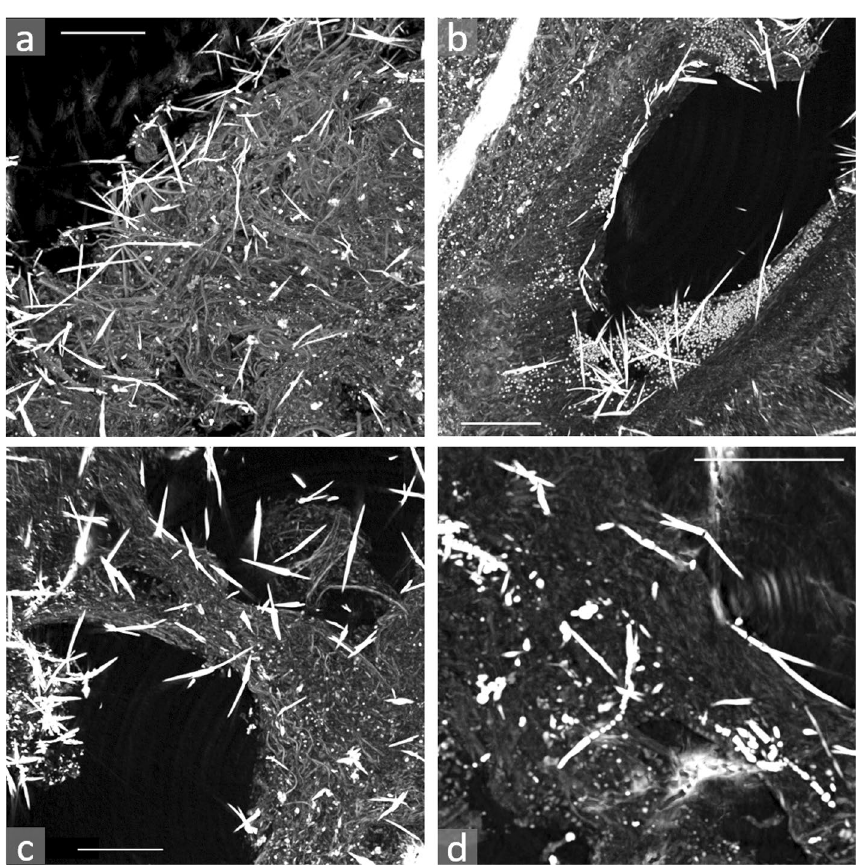
Figure 1. XPCµT data acquired at the I13-2 beamline at the Diamond light XPCµT data acquired at the I13-2 beamline at the Diamond light source on lung tissue fragments embedded in paraffin. Brighter grey levels correspond to more absorbing (i.e. denser) material. For ease of view, the volumes are shown as projections on a plane of 300 slices, each 0.332 μm-thick (total thickness ~ 99 μm). In all images, several AB can be clearly identified as the white elongated object. ( a ) Sample A AB in are visible along with lung structures, such as bronchioles and alveoli. ( b ) Sample C an alveolar sac with AB accumulating on its walls, preferentially at its end, where hypercellularity occurs. ( c ) Sample D alveoli or bronchioles with AB penetrating the lung parenchyma. ( d ) Sample A magnification showing a variety of typical AB with sheatlike or beaded coatings. In all images, the scale bars are 100 μm long and the pixel size is 0.332 × 0.332 μm 2